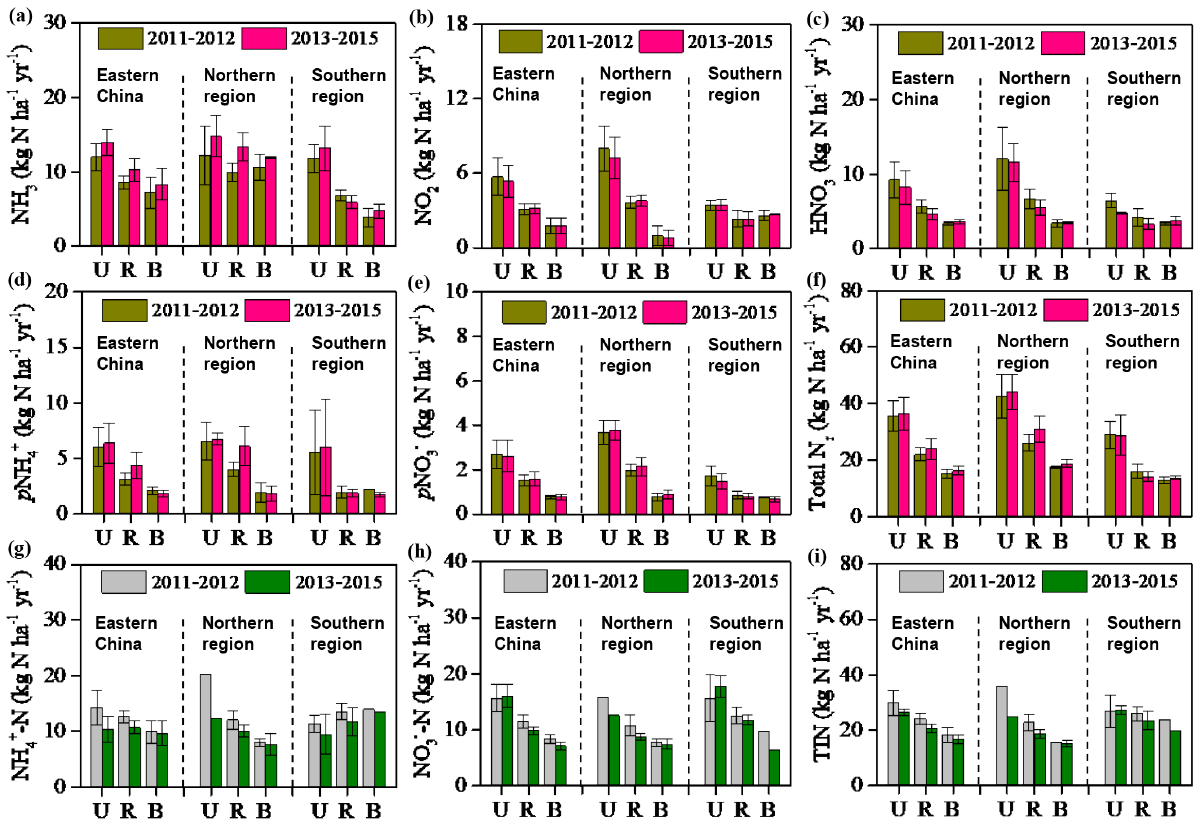
Figure 5. Comparison of dry deposition of (a) NH 3 , (b) NO 2 , (c) HNO 3 , (d) p NH + in air and wet/bulk deposition of NH + 2011–2012 period and the 2013–2015 period for different land use types in eastern China and its northern and southern regions. U, R, and B denote urban, rural, and background sites respectively. The number of sites for each land use type in each region can be found in Table S1 in the Supplement. The error bars are the standard errors of